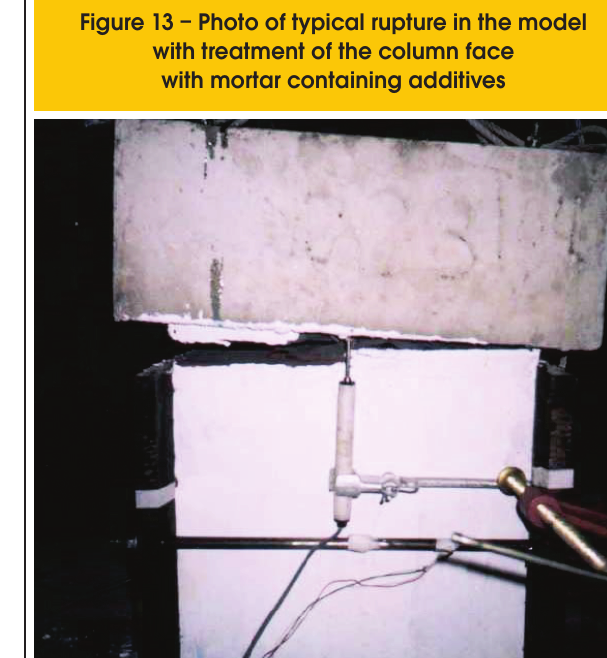
Figure 13 – Photo of typical rupture in the model with treatment of the column face with mortar containing